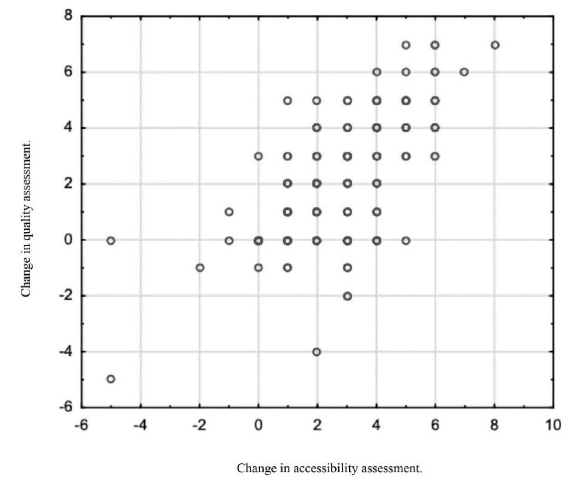
Figure 9. Correlation between change in the assessment of accessibility and change in the assessment of